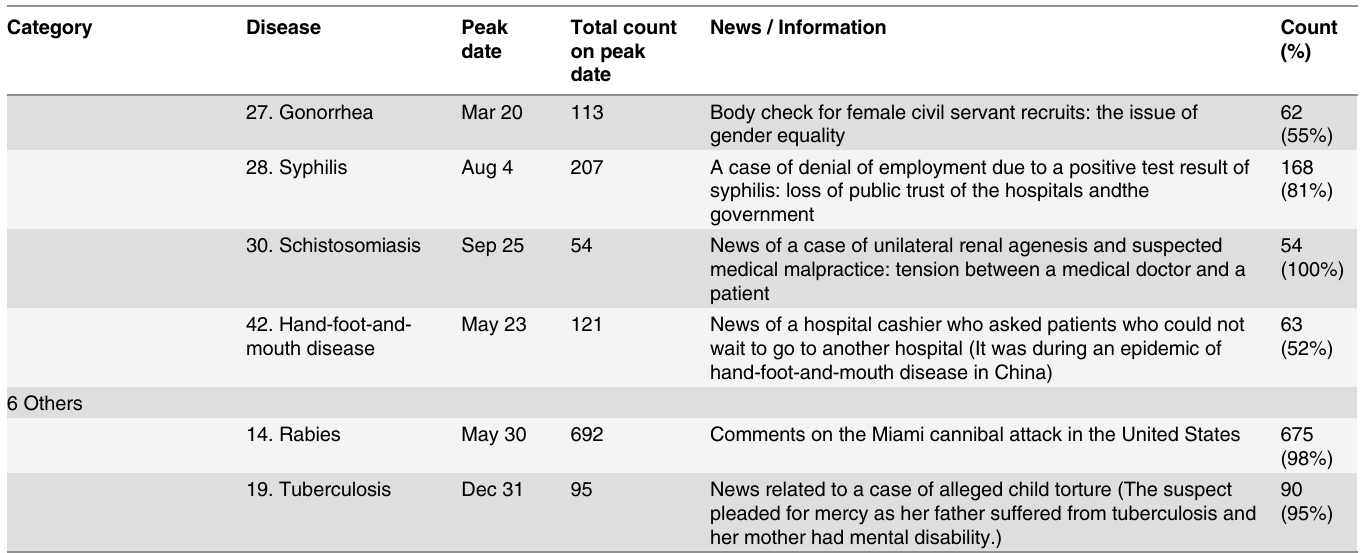
secondary data analysis of the WeiboScope dataset of 2012. All the Weibo posts in the original WeiboScope dataset were publicly available posts. No attempt was made to inform Weibo users of the current study. The data had been de-identified before the current analysis